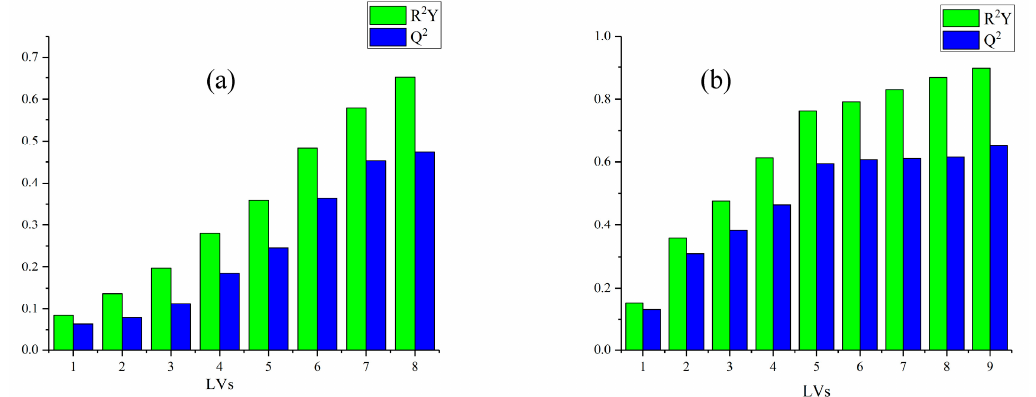
Figure 5. Latent variables (LV S ), R 2 Y and Q 2 values of PLS-DA of Raw ( a ) and SD ( b ) spectra for Figure 5 . Latent variables (LV S ), R 2 Y and Q 2 values of PLS-DA of Raw( a ) and SD( b ) spectra for Lingzhi species. Lingzhi species . Table 2. Results of PLS-DA models of di ff erent species basing on di ff erent data Table 2 . Results of PLS-DA models of different species basing on different data matrices . Data Matrices